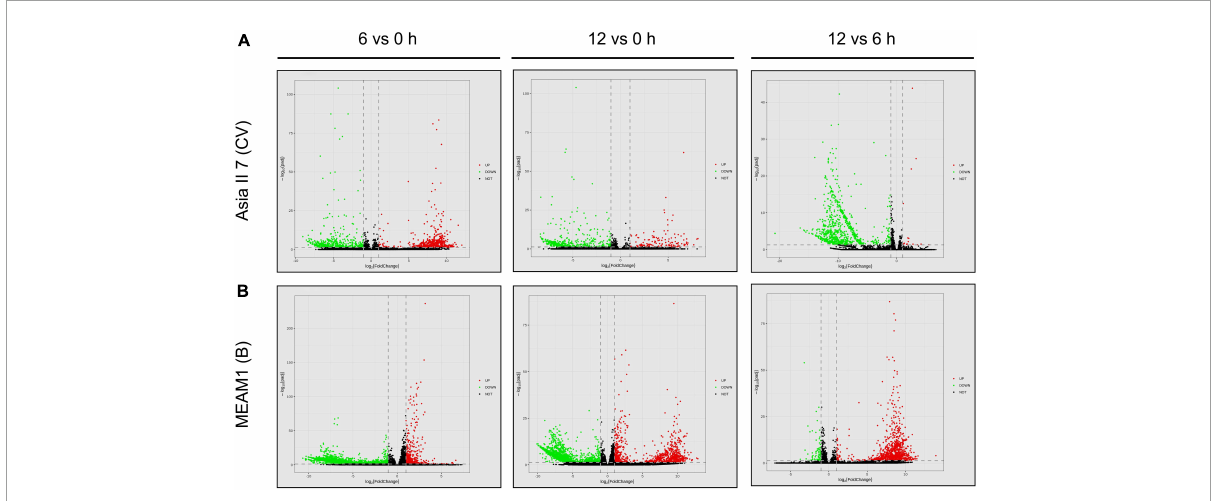
FIGURE1 Pairwise comparisons of differentially expressed genes (DEGs) among VF and AVF whiteflies (Asia II 7 and MEAM1). The cut-off FC ratio ≥ 2 for up-regulated genes and FC ratio ≤− 2 for down-regulated genes with Padj < 0.05 were used to identify DEGs. DEGs among (A) Asia II 7 and (B) MEAM1 cryptic species after 6 and 12 h of CLCuMuV infection as compared to those fed on uninfected cotton plants. Each gene is represented by scattered dots in the figure. Red colored dots represent the up-regulated genes, green colored dots indicate down-regulated genes while black color indicates non-significantly expressed genes.